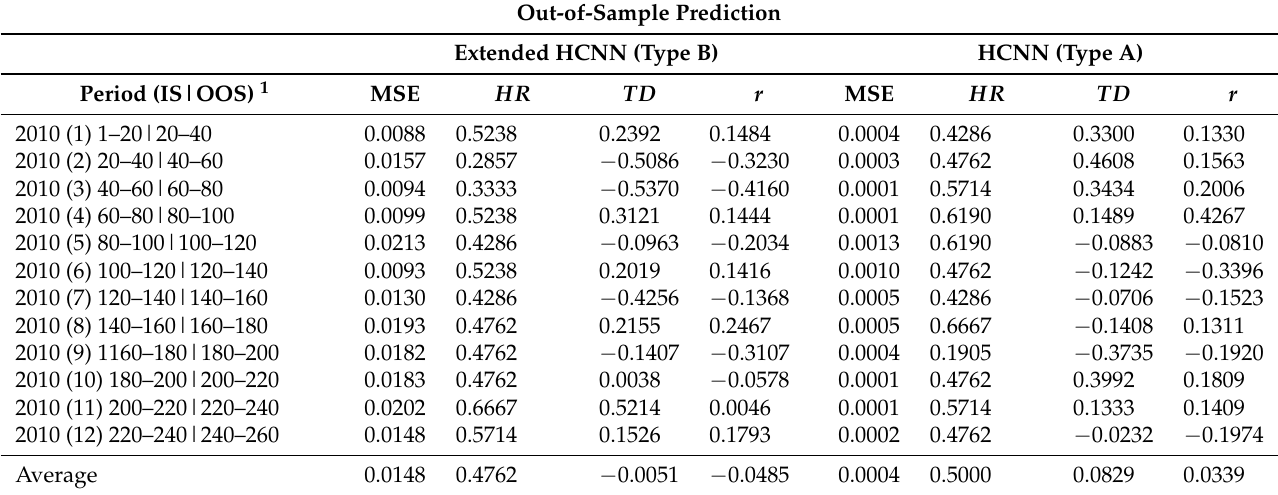
Table 3. Evaluation of Prediction Models. Rolling out-of-sample forecasts measured by MSE = mean square error, HR = hit rate, TD travel-distance and r = correlation coefficient. 1 The period in trading days of the record is divided into the start of the initial start of the learning process in the respective in-sample phase (IS) and the actual out-of-sample phase (OOS) for prediction using a rolling time window with a length of 20 periods.